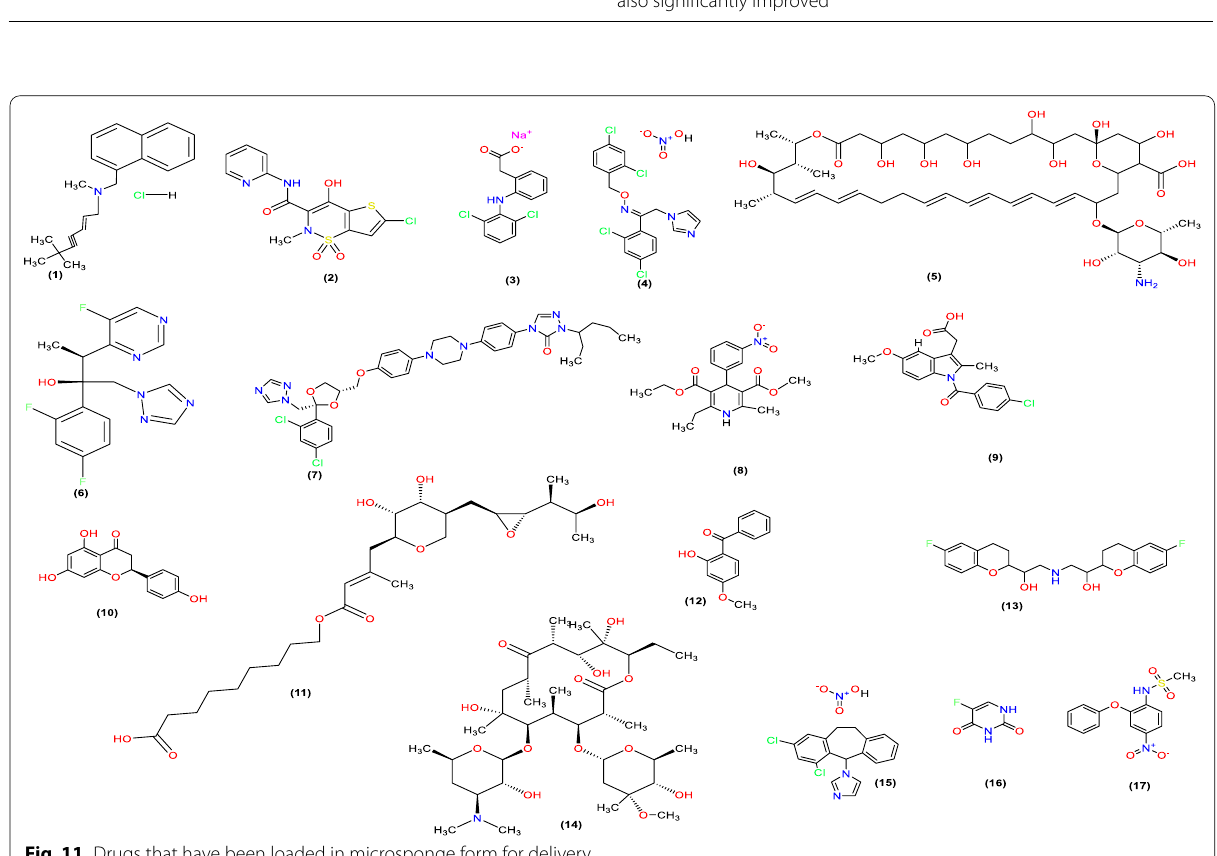
Fig. 11 Drugs that have been loaded in microsponge form for